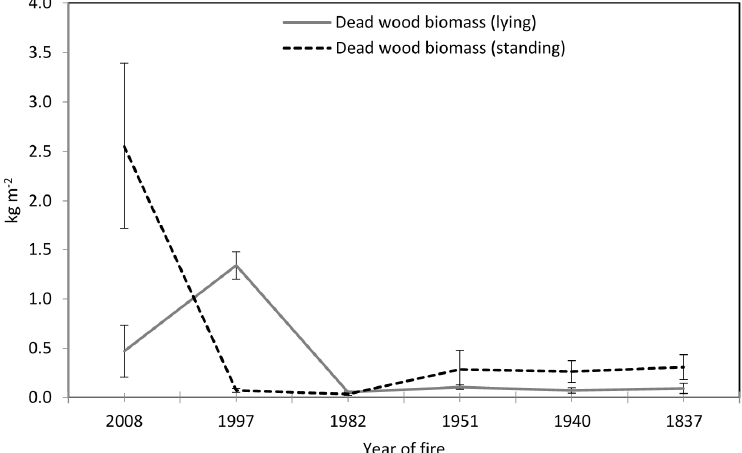
Figure 3. Average standing and lying dead wood biomass (kg·m − 2 ) in a fire chronosequence.